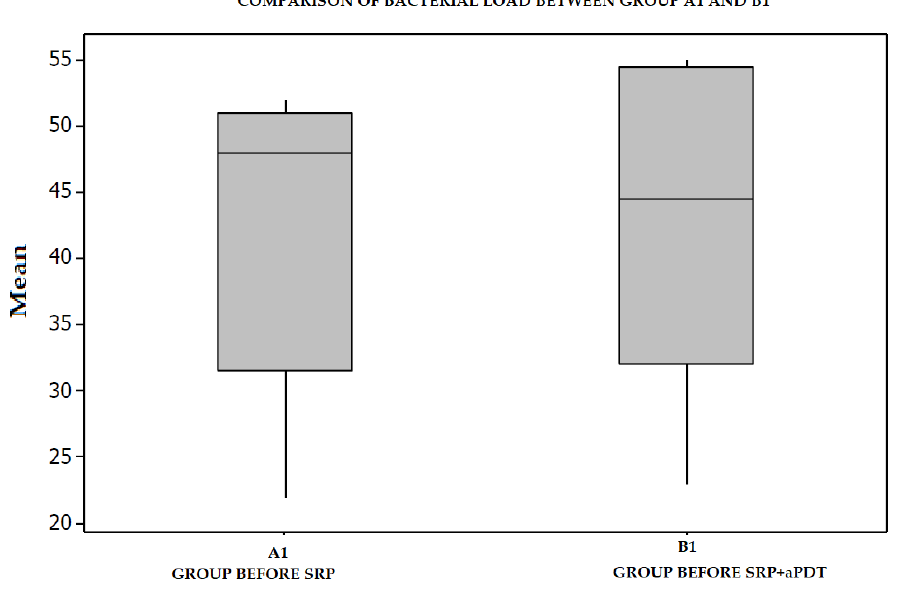
Figure 4. Mean bacterial count by groups, before